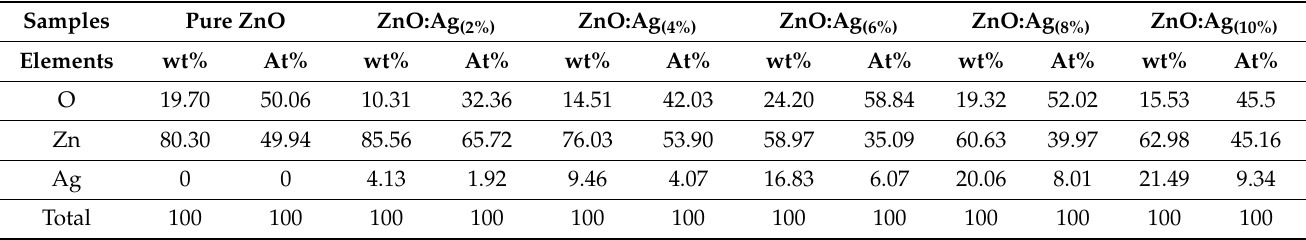
Figure 6. EDX spectra of samples ( a ) Pure ZnO, ( b ) ZnO:Ag (2%) , ( c ) ZnO:Ag (4%) , ( d ) ZnO:Ag (6%) , ( e ) ZnO:Ag (8%) , and ( f ) ZnO:Ag (10%) . Table 2. EDX analysis of pure and Ag-doped ZnO nanoparticles.